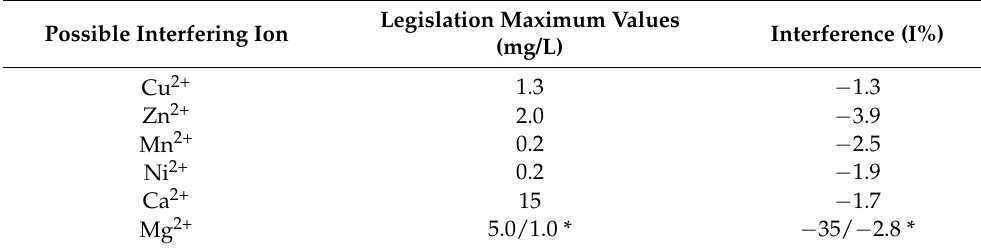
Table 1. Assessment of possible interfering ions in the determination of iron (III) according to legislated values, UNFAO, United Nations Food and Agriculture Organization.